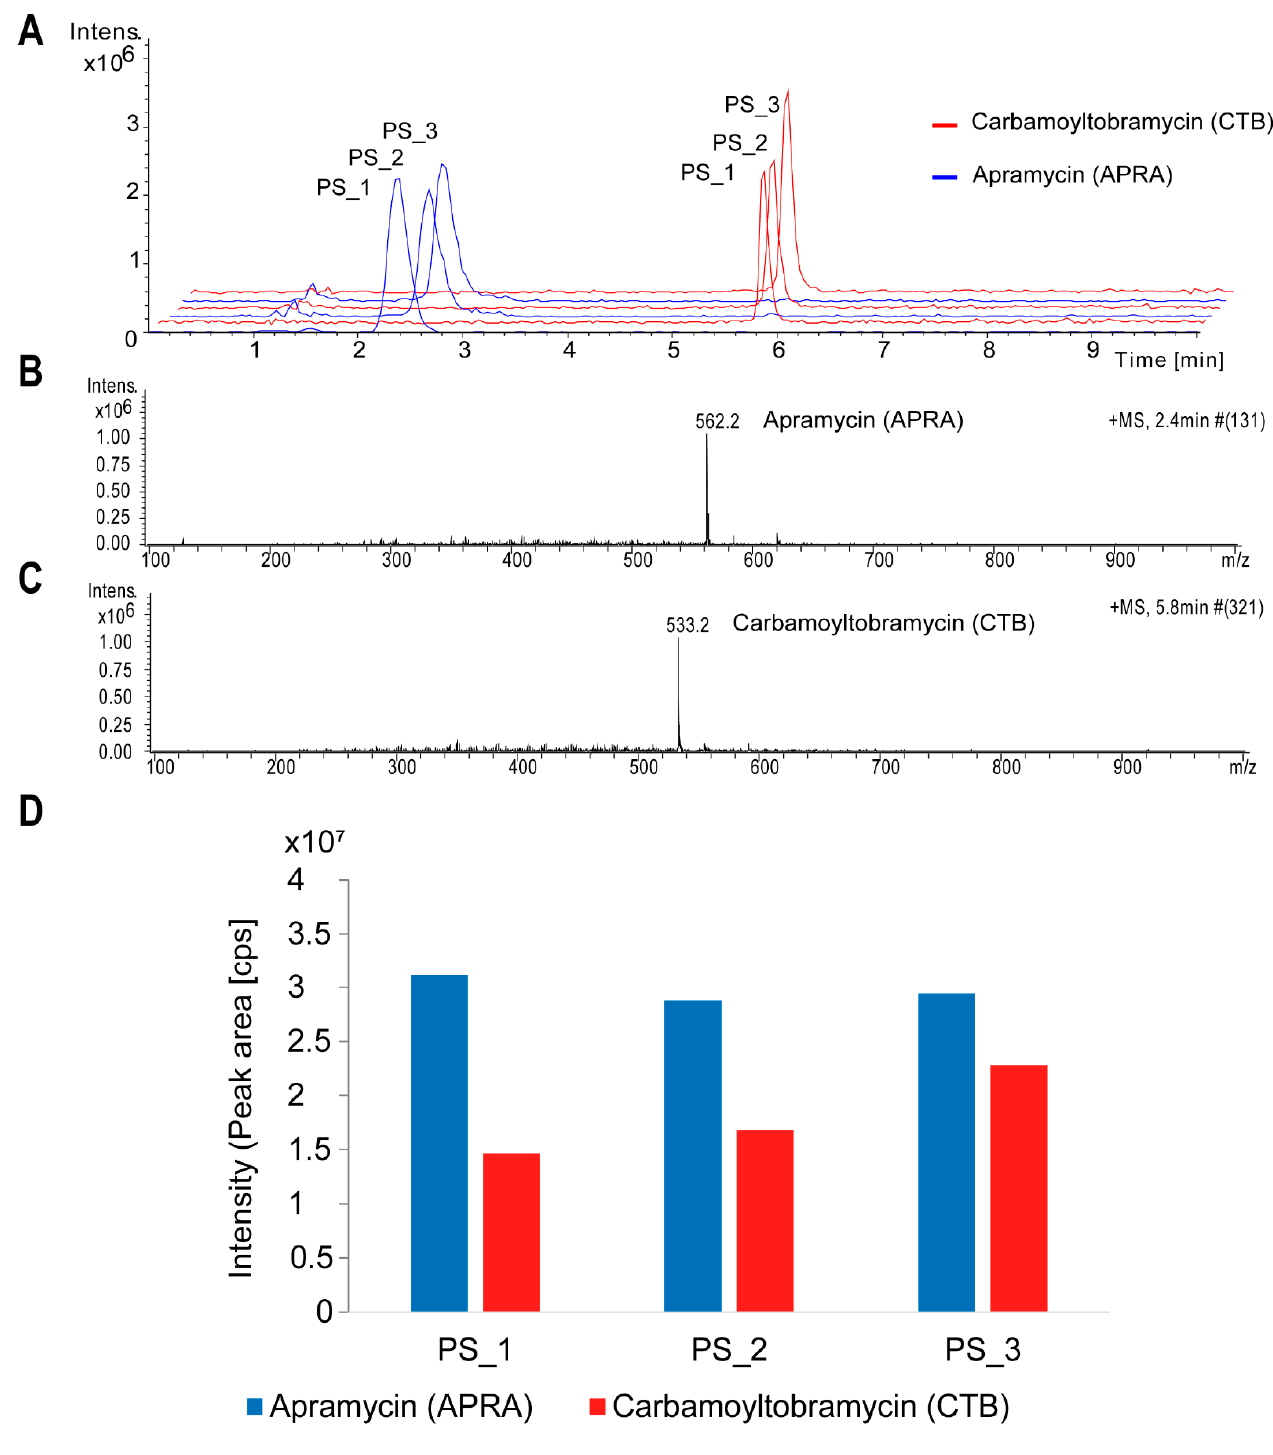
Figure 3. Apramycin (APRA) and carbamoyltobramycin (CTB) production in Streptoalloteichus tenebrarius 2444 PS (in triplicate, PS_1–3). ( A ) HPLC-ESI MS spectra for APRA and CTB. ( B ) Extracted ion chromatogram (EIC) for APRA ( m / z 562, positive mode). ( C ) EIC for CTB ( m / z 533, positive mode). ( D ) The intensity (peak area) for CTB and APRA mass peaks: cps, counts per second (the number of ions that hit the detector per unit of time).